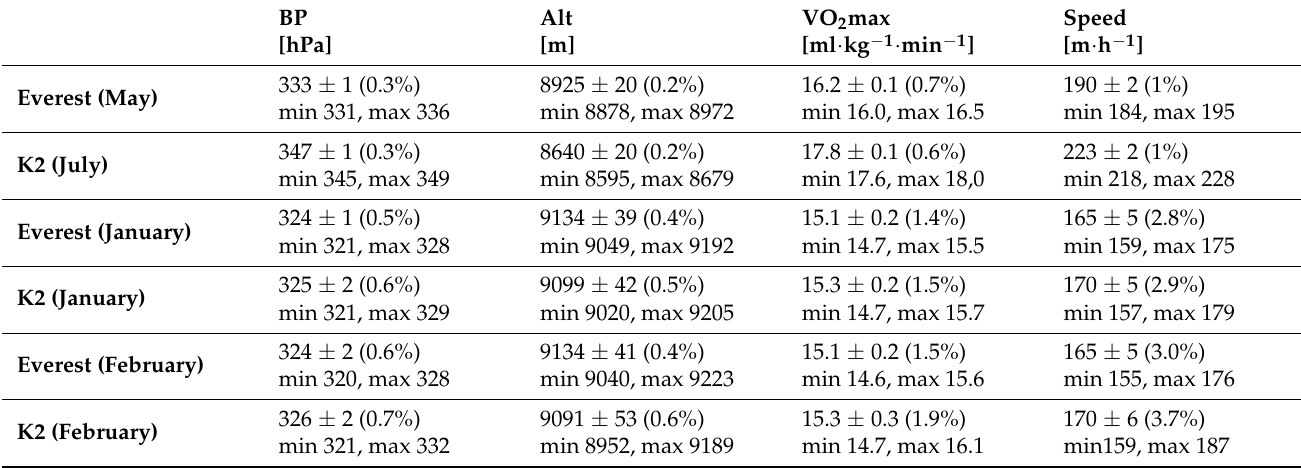
Table 1. Barometric pressure and BP-dependent parameters for the months we analyzed: monthly means ± standard deviation (SD), coefficient of variation (CV%), and minimum and maximum values. Sample size—41 monthly means (1979–2019).